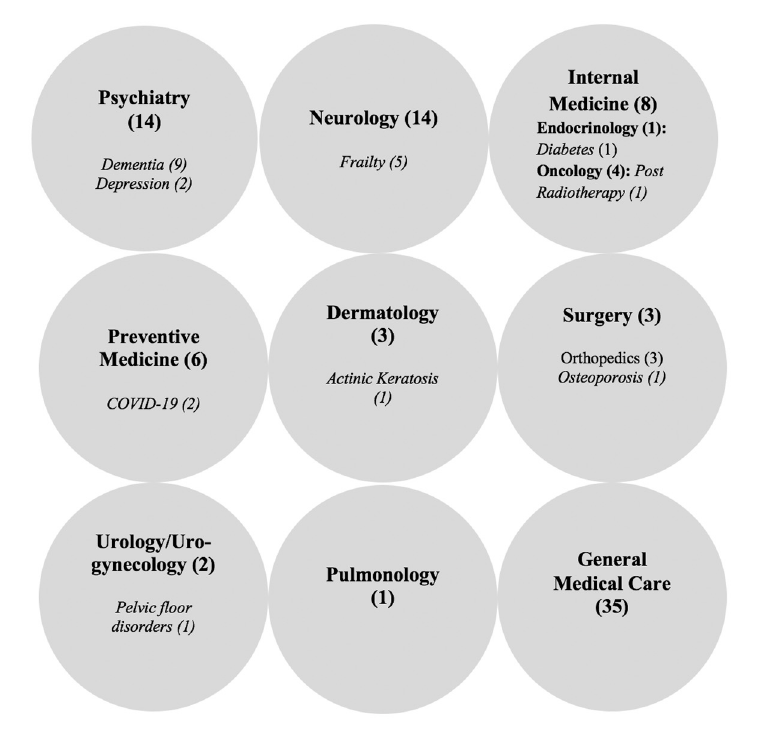
Figure 2. Medical specialty and sub-specialty/specific disease conditions.